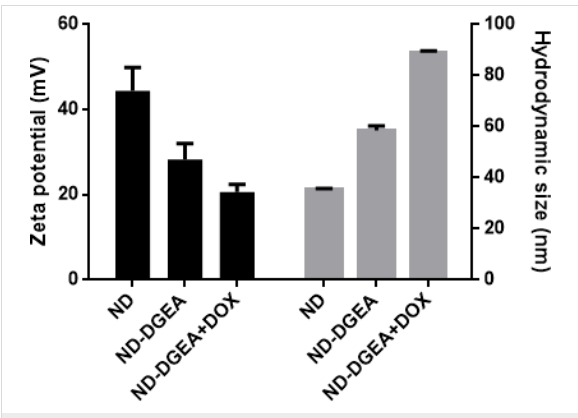
Figure 4: Zeta potential and hydrodynamic size of ND, ND-DGEA, and